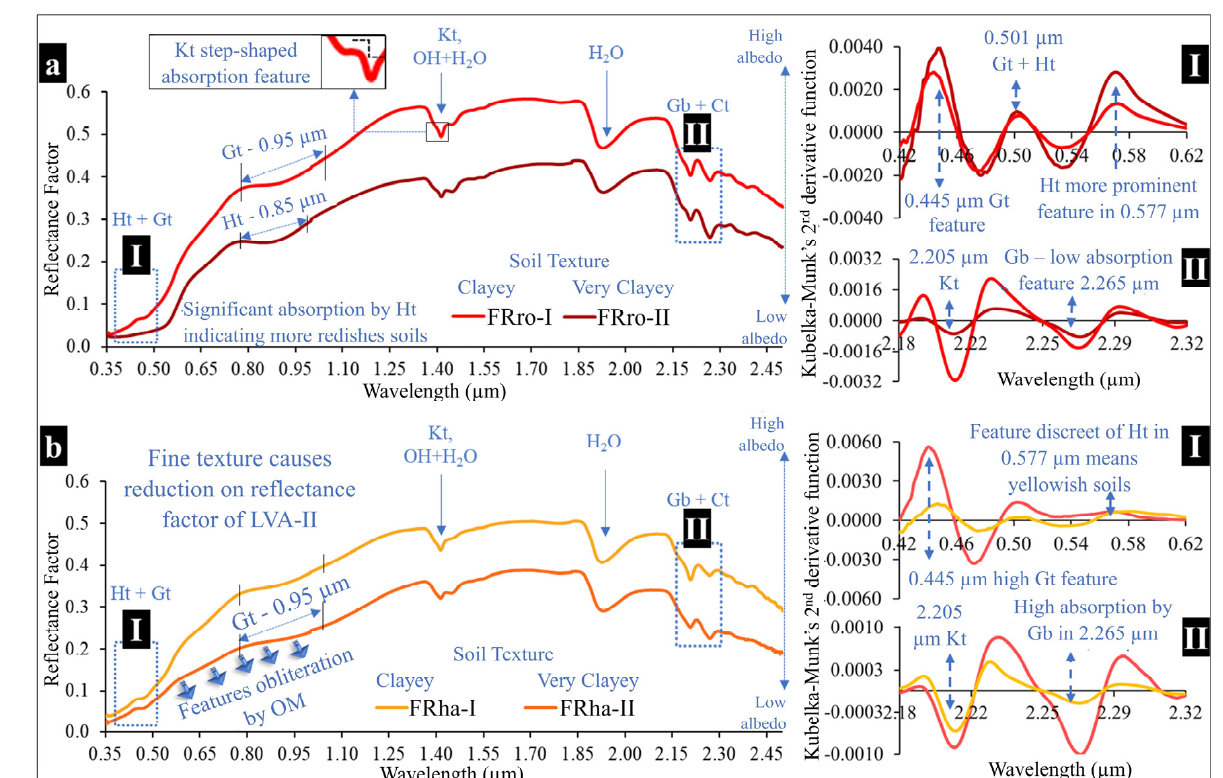
Figure 5. Interpretation of the spectral behavior of ( a ) Rhodic Ferralsol (FRro-I and FRro-II) and ( b ) Haplic Ferralsol (FRha-I and FRha-II). Ht: Hematite, Gt: Goethita; Kt: Kaolinite; Gb: Gibbsite; OM: Organic